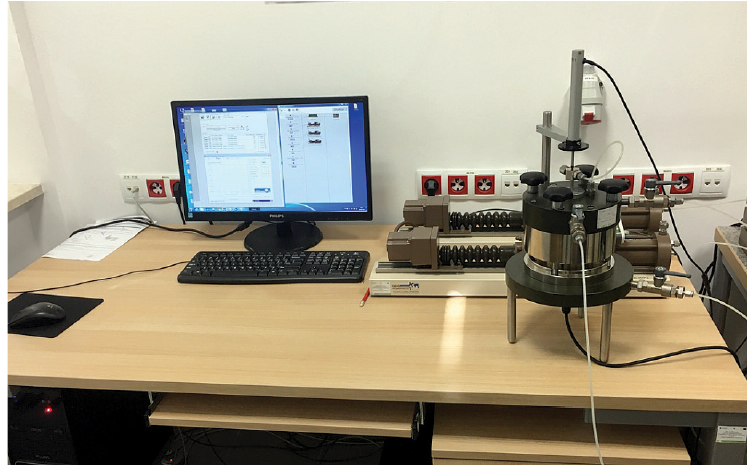
Figure 2. Consolidation cell assembly during the